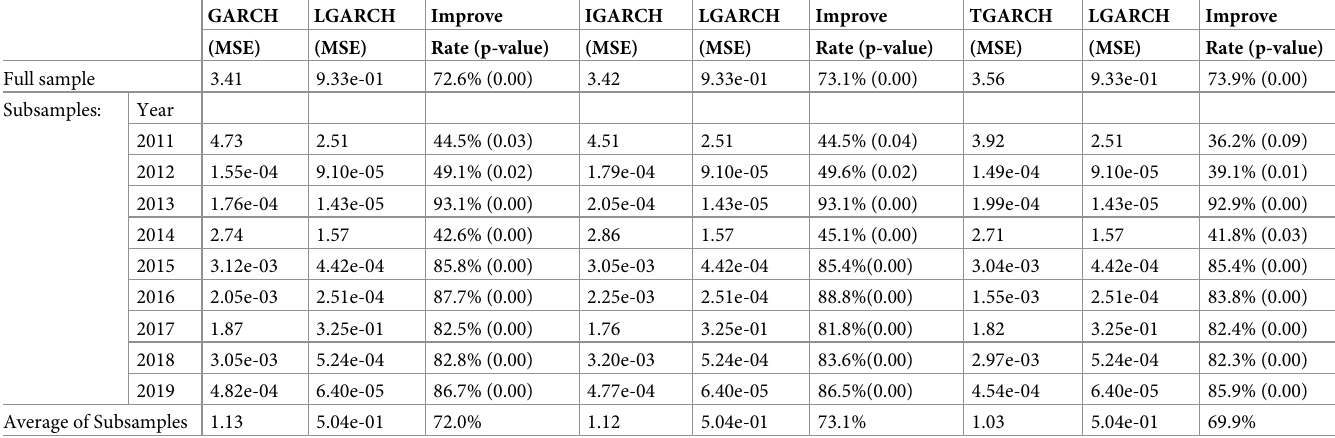
Table 6. Out of sample forecasting with realized variance. This table presents the oil futures volatility out-of-sample forecasting results of Liquidity-adjusted GARCH (LGARCH) with other three GARCH models against the realized variance using the Mean Squared Error (MSE). The p-values for statistical differences of the forecasting errors are also presented. The LGARCH model outweighs all other three models in both full sample and most subsample tests. Where en = � 10 n , e.g. e − 02 = � 10 − 2